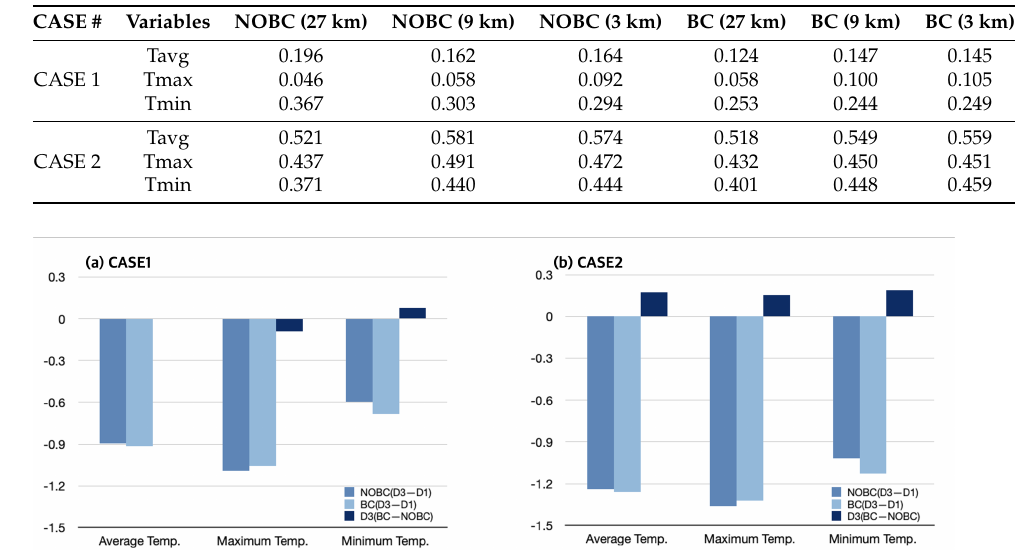
Table 3. Averaged correlation coefficient for 94 stations.